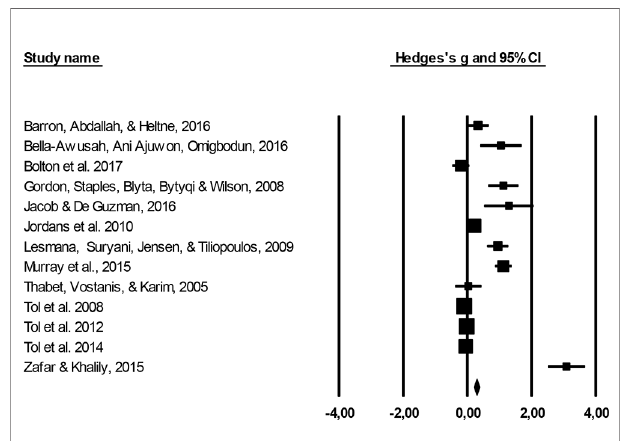
FIGURE 4 | Forest plot of combined outcomes.